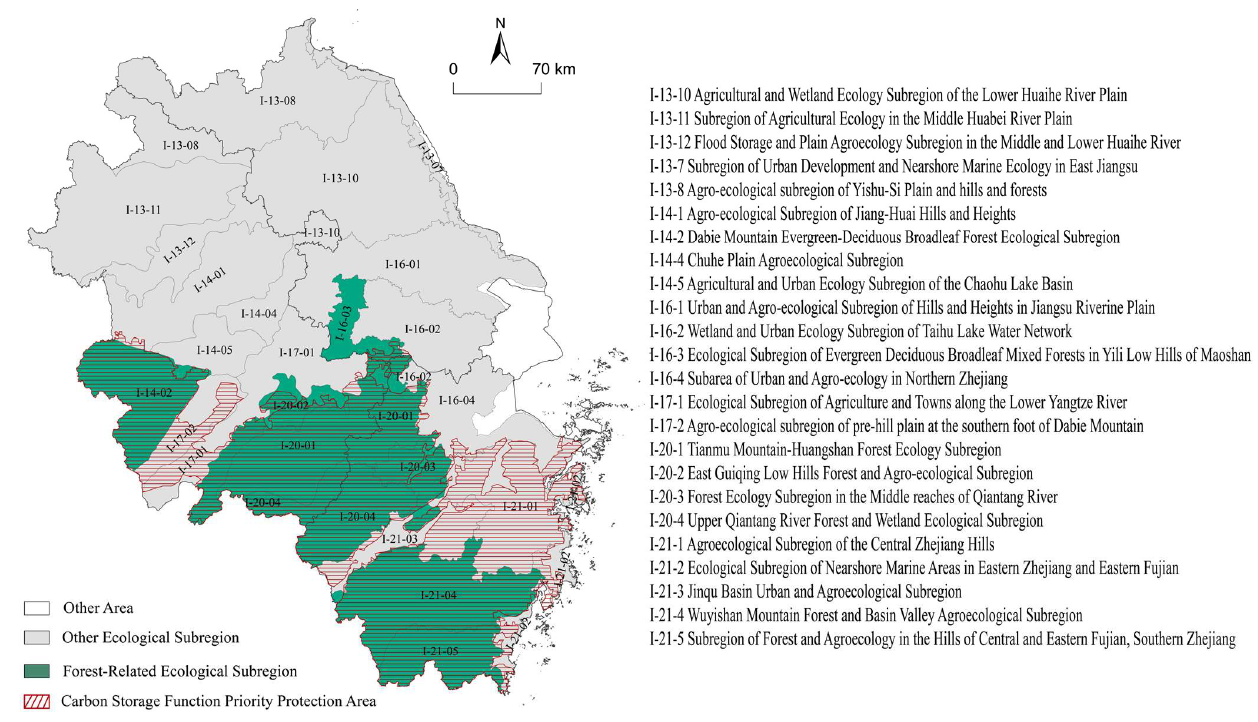
Figure 9. Comparison between the priority protected area for carbon storage function and the established ecological function zoning scheme in YRD.